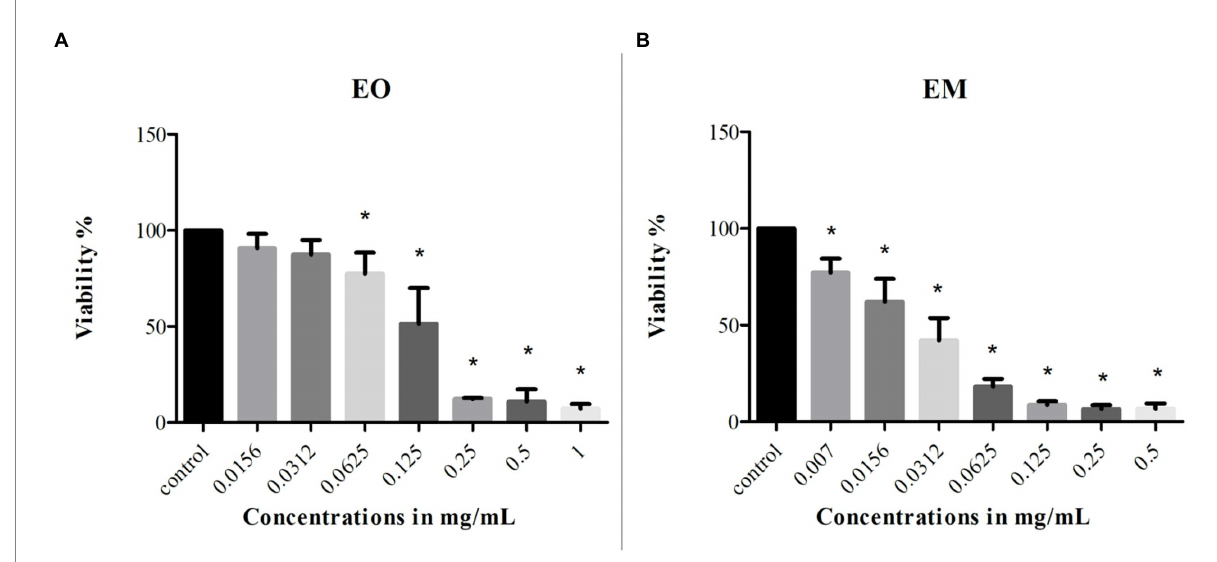
FIGURE 7 Cytotoxicity of cinnamon essential oil (A) and cinnamon emulsion (B) on MRC-5 (fetal fibroblasts) cell line. The experiment was done three times in hexaplicates. Statistical significance was * p < 0.05.